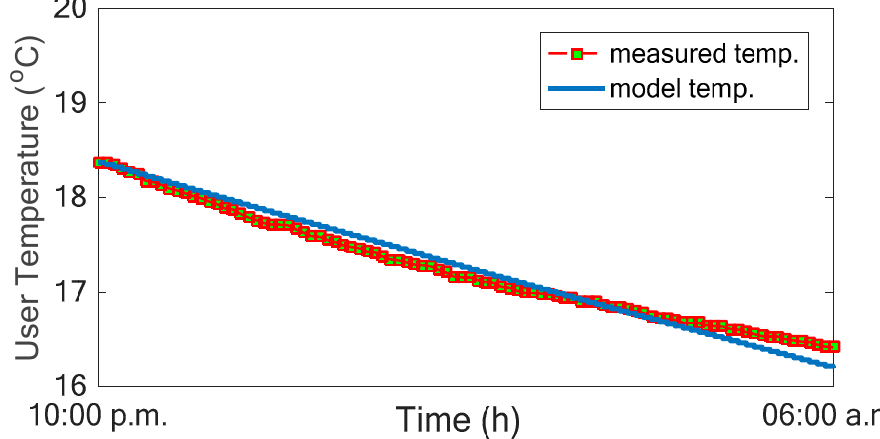
Figure 4. User temperature ( V C 1 ) profile: measured data against model results from 10 p.m. to 6 a.m.